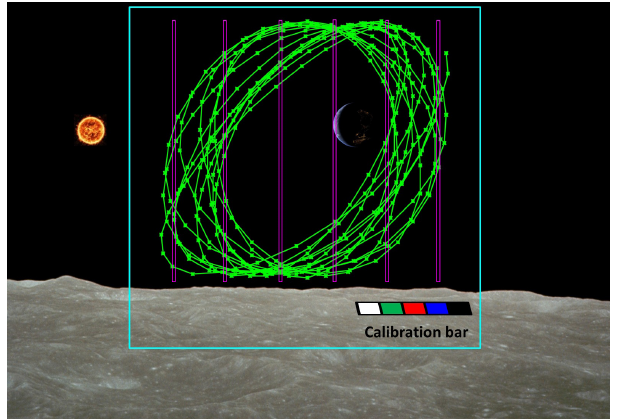
Figure 9. Visual positions of the Earth’s center during 2026 (green line) from the south pole of the Moon (point S in Fig. 6) and possible positions of slits of the spectrometer (violet). The blue square is ∼ 18–20 ◦ FOV of fixed-mount camera. The calibration bar is used to calibrate color images from a wide-angle camera. Lunar surface is from the photo taken by NASA